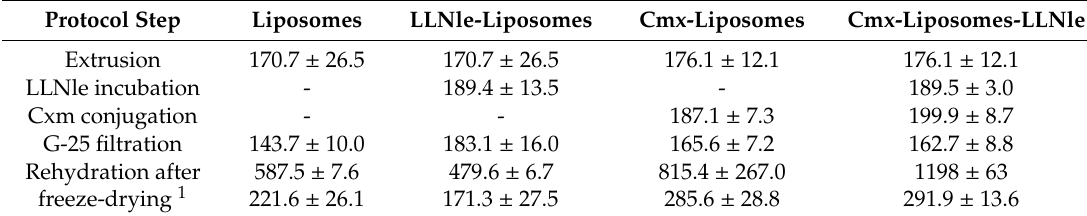
Table 1. Dimensions (mean diameter, nm) of the investigated liposomes monitored at di ff erent steps of protocol preparation.